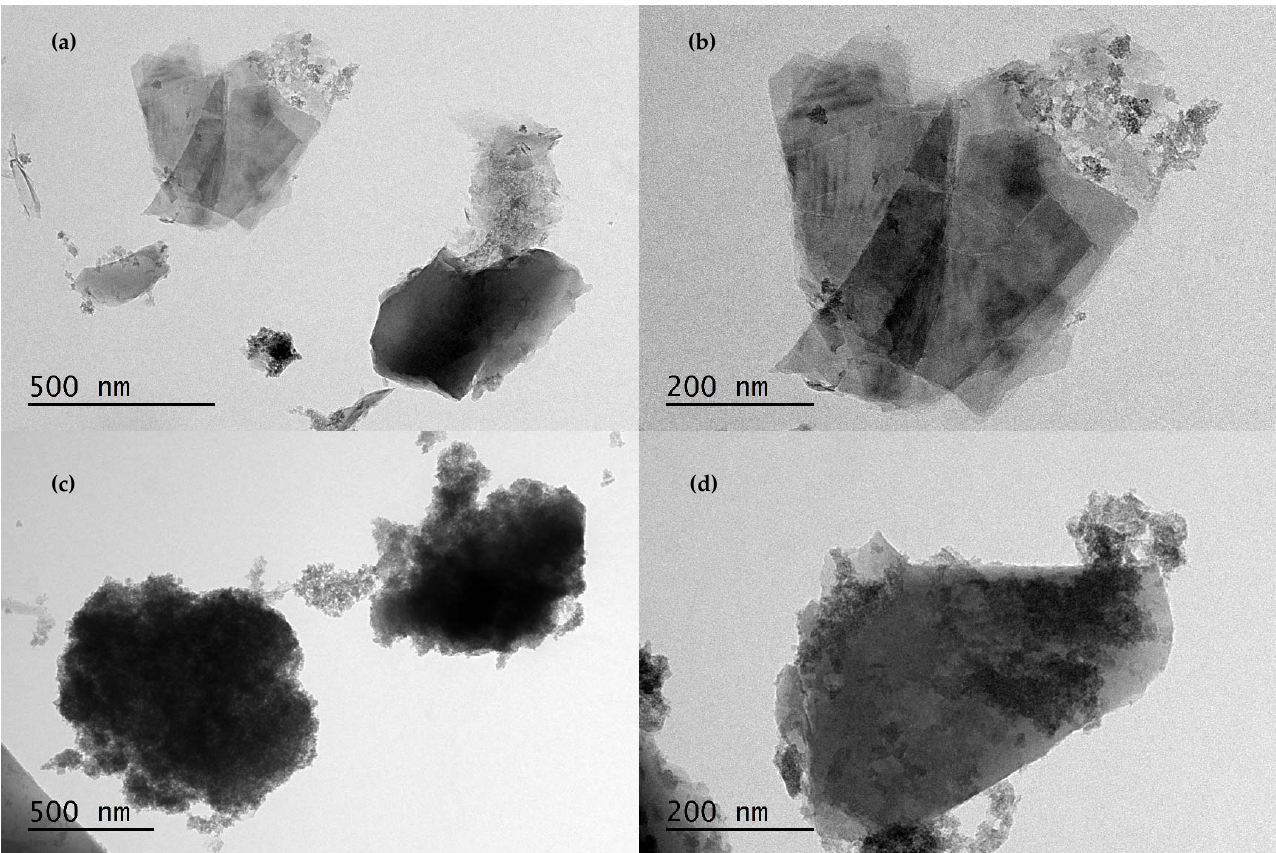
Figure 4 TEM photograph of the catalyst; ( a , b ) Raw Pumice and ( c , d ) Iron Coated Pumice Figure 4. TEM photograph of the catalyst; ( a , b ) Raw Pumice and ( c , d ) Iron Coated